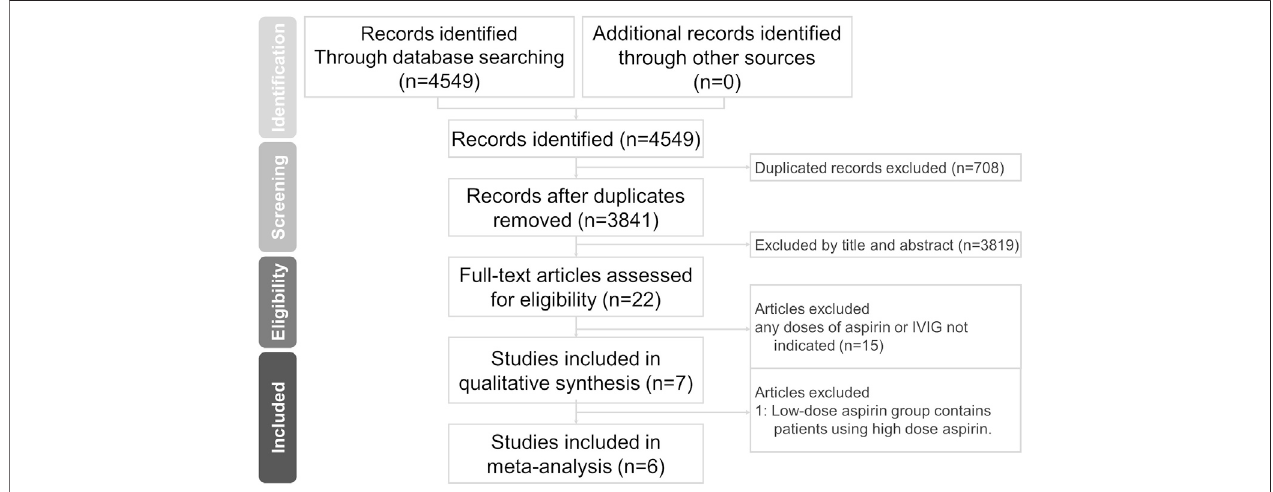
FIGURE 1 | Preferred Reporting Items for Systematic Reviews and Meta-Analyses (PRISMA) fl ow diagram of the study search and selection process. IVIG, intravenous immunoglobulin.